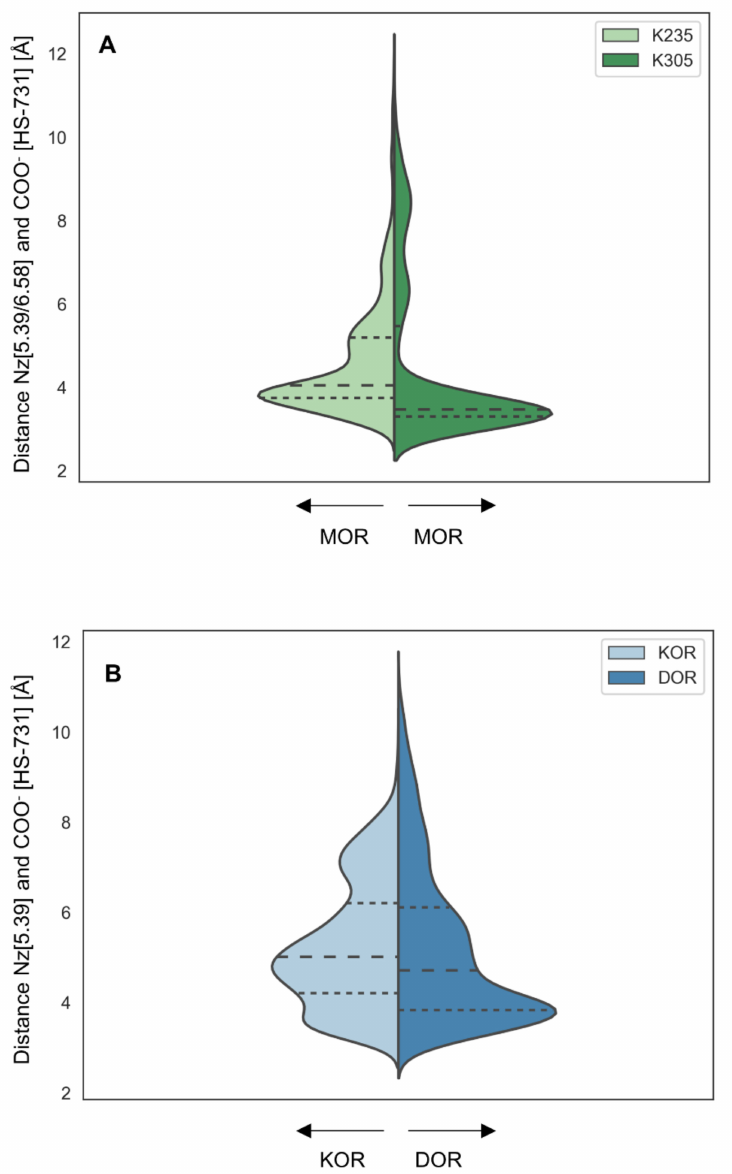
Figure 7. Ionic interaction distances. ( A ) Distances between K235 5.39 (Nz) or K305 6.58 (Nz) in the MOR and the carboxylate of HS-731. ( B ) Distances between K227 5.39 (KOR, Nz) or K214 5.39 (DOR, Nz) and the carboxylate moiety of HS-731. Dashed lines represent quantile. The width of the plot corresponds to the frequency of the measured